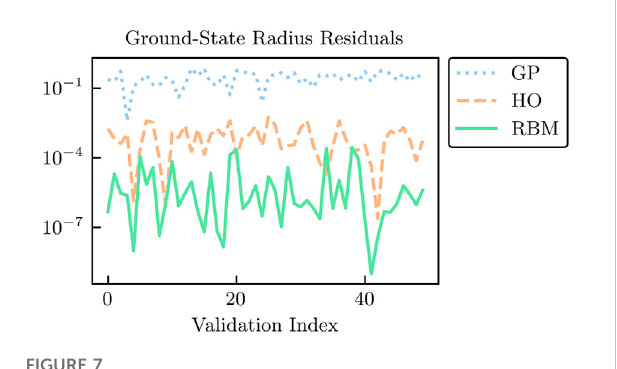
(cid:21)(cid:21)(cid:21)(cid:21)(cid:21) (cid:22) 〈 R 2 〉 and